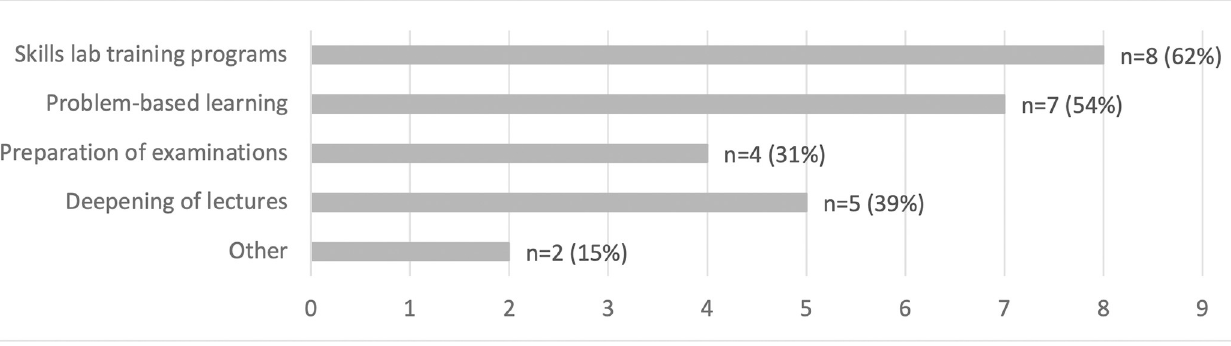
PLOS ONE | https://doi.org/10.1371/journal.pone.0278872 December14,